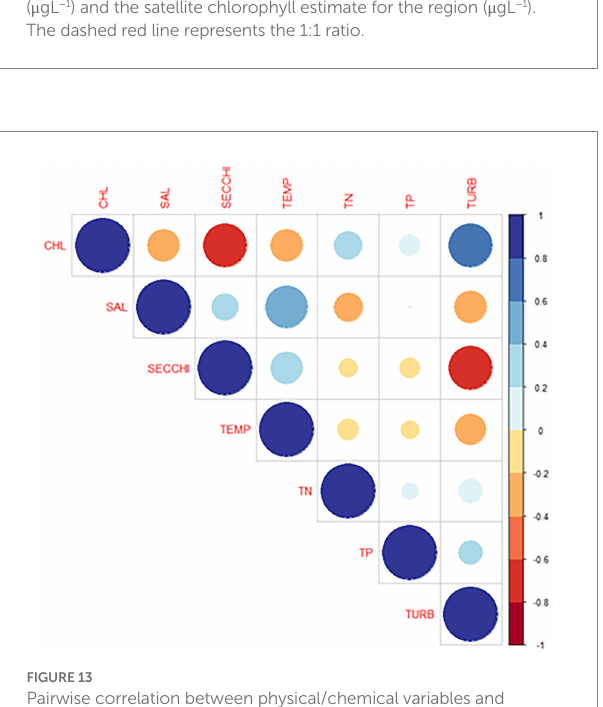
FIGURE 11 Natural log of chlorophyll concentrations (mg m − 3 ) measured by MODIS-Aqua satellite for an 8-day composite for November 2017 and August 2018. The red square denotes the sampling region. SJR, St. John’s River Estuary; AUG, St. Augustine Inlet; PDL, Ponce de Leon Inlet.